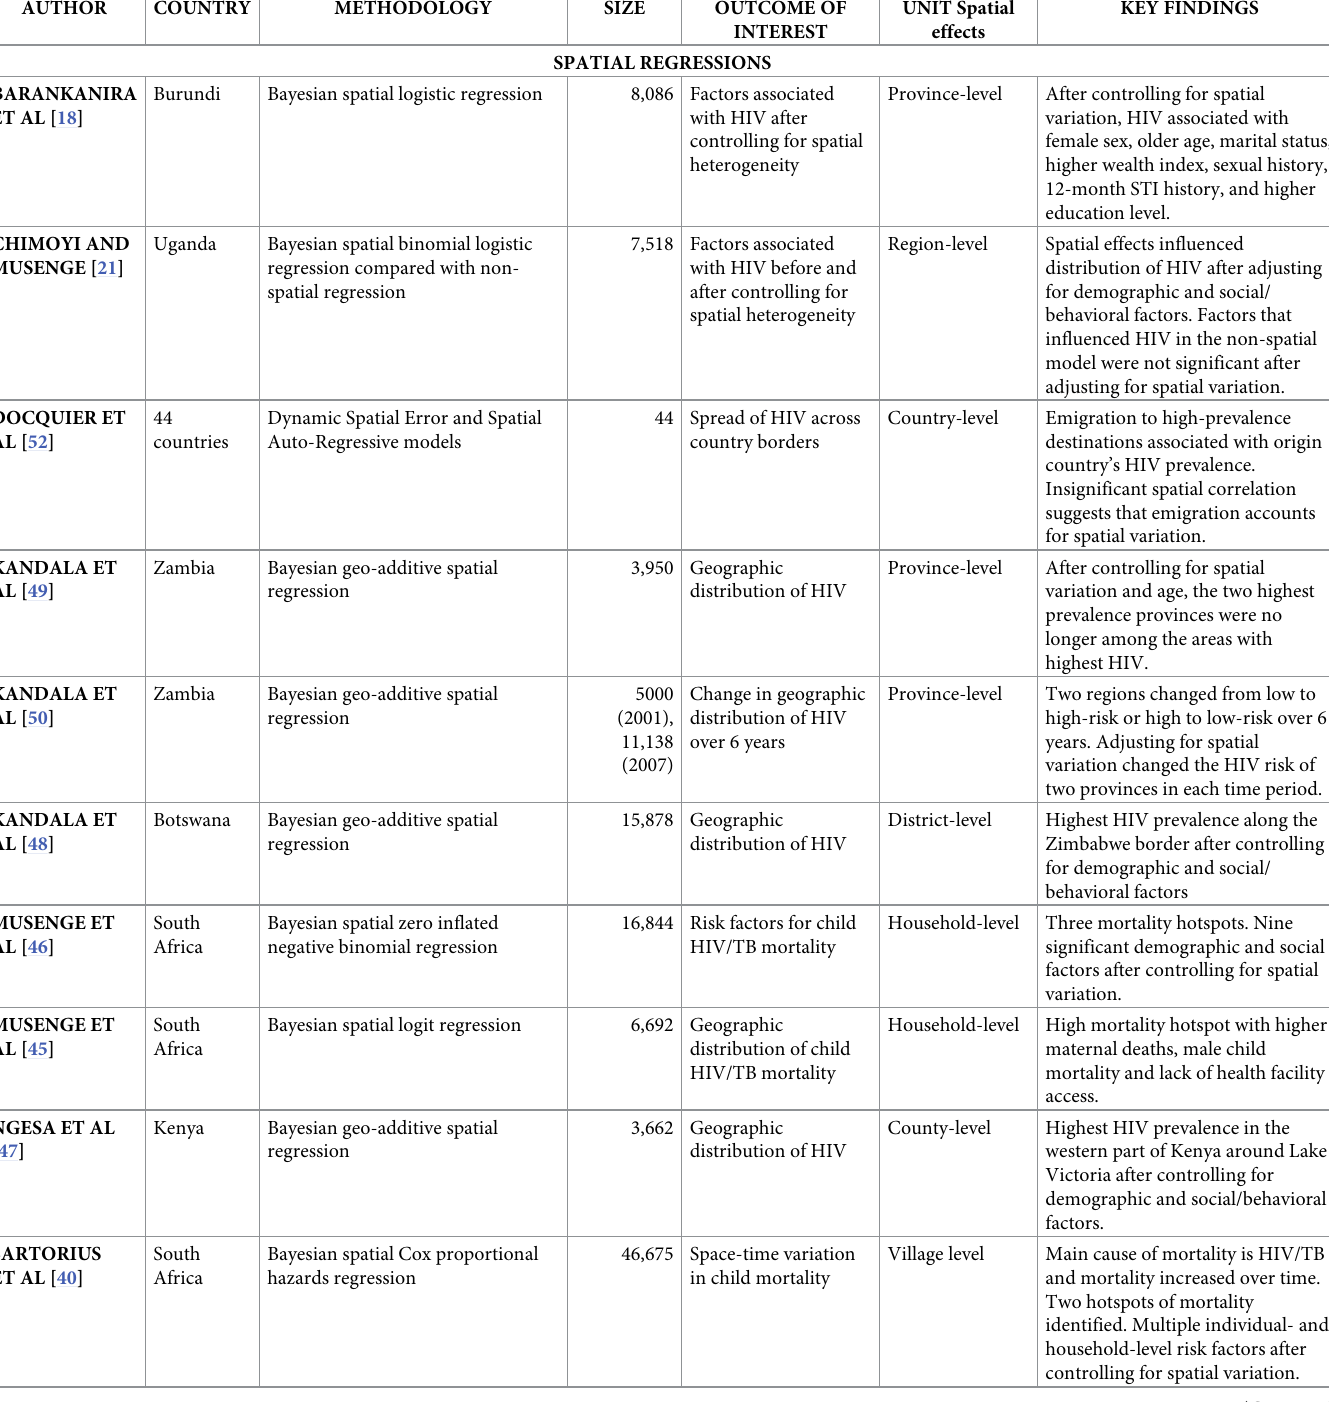
Table 3. Studies performing spatial regressions, regressions with spatially varying coefficients, and joint spatial